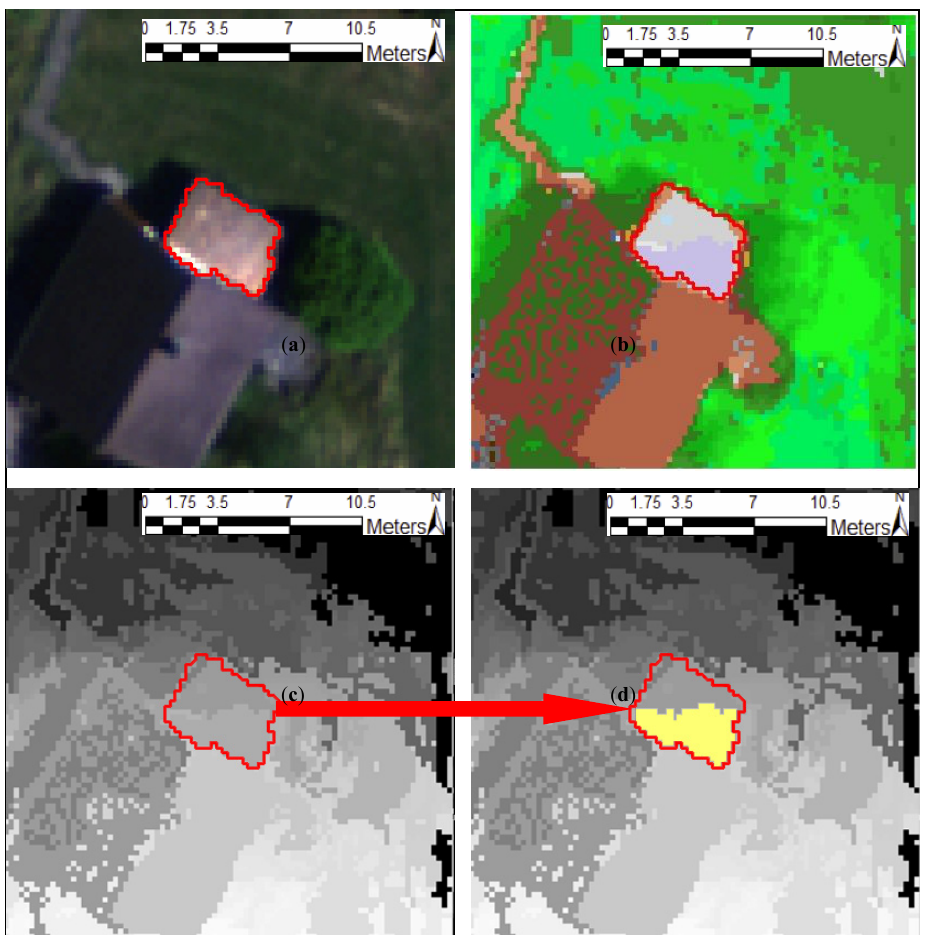
Figure 7. Target (mapped) image-object selection in the SIAM™ map of the Leica image at fine semantic granularity, refer to Equation (12). ( a ): The closed red contour identifies a reference image-object of the LC class “ buildings” , selected by an expert photointerpreter in the Leica image. ( b ): SIAM™’s pre-classification map of the Leica image at fine semantic granularity. The boundary of the reference segment is superimposed in red. ( c ): SIAM™’s segmentation map automatically generated from the SIAM™’s pre-classification map at fine semantic granularity. Each (connected) segment is identified by a different integer value and (should be) depicted in a different gray-tone. The boundary of the reference segment is superimposed in red. ( d ): The yellow segment is the target (mapped) object selected according to the reference-test segment pair selection criterion, see Equation (12). Note that the relevance of the road/building adjacency and spectral similarity effect, discussed in Figure 6 as a possible cause of undersegmentation errors, decreases in the SIAM™’s map at fine semantic granularity, which is more prone to oversegmentation